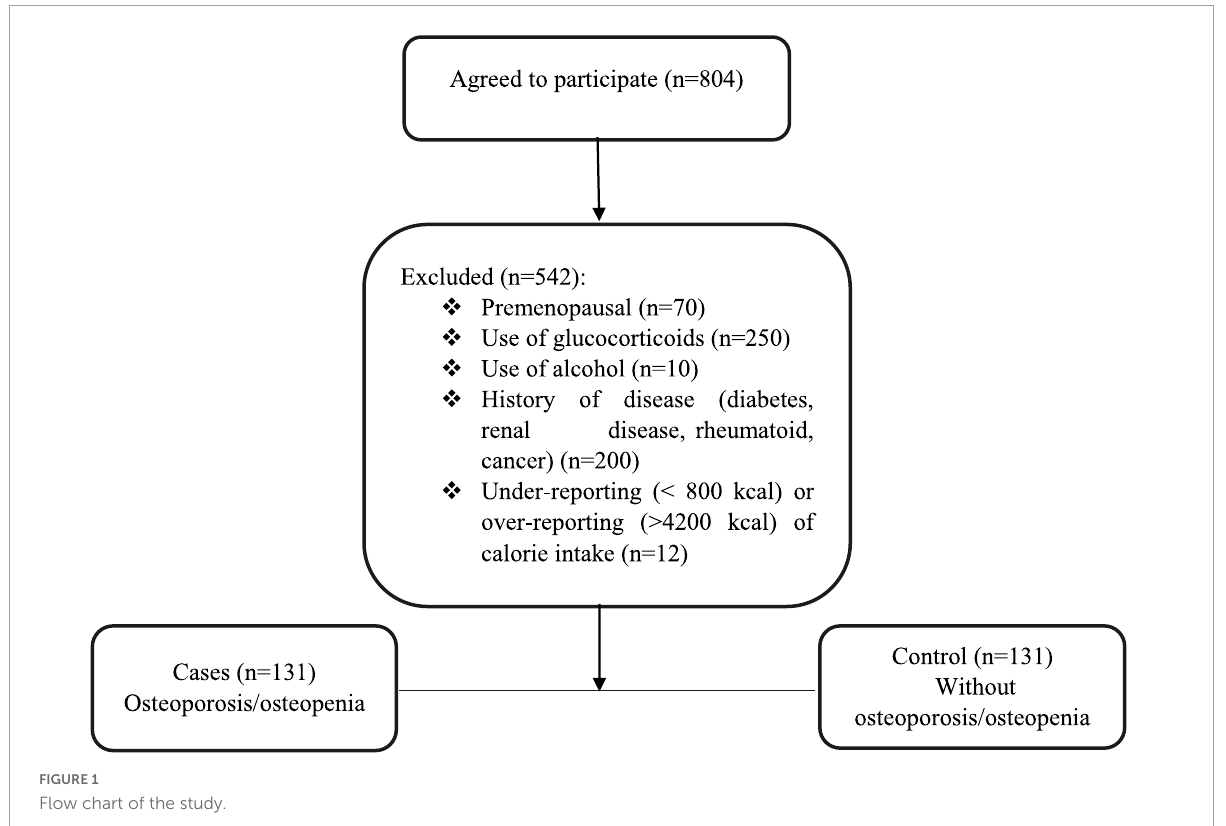
FIGURE1 Flow chart of the